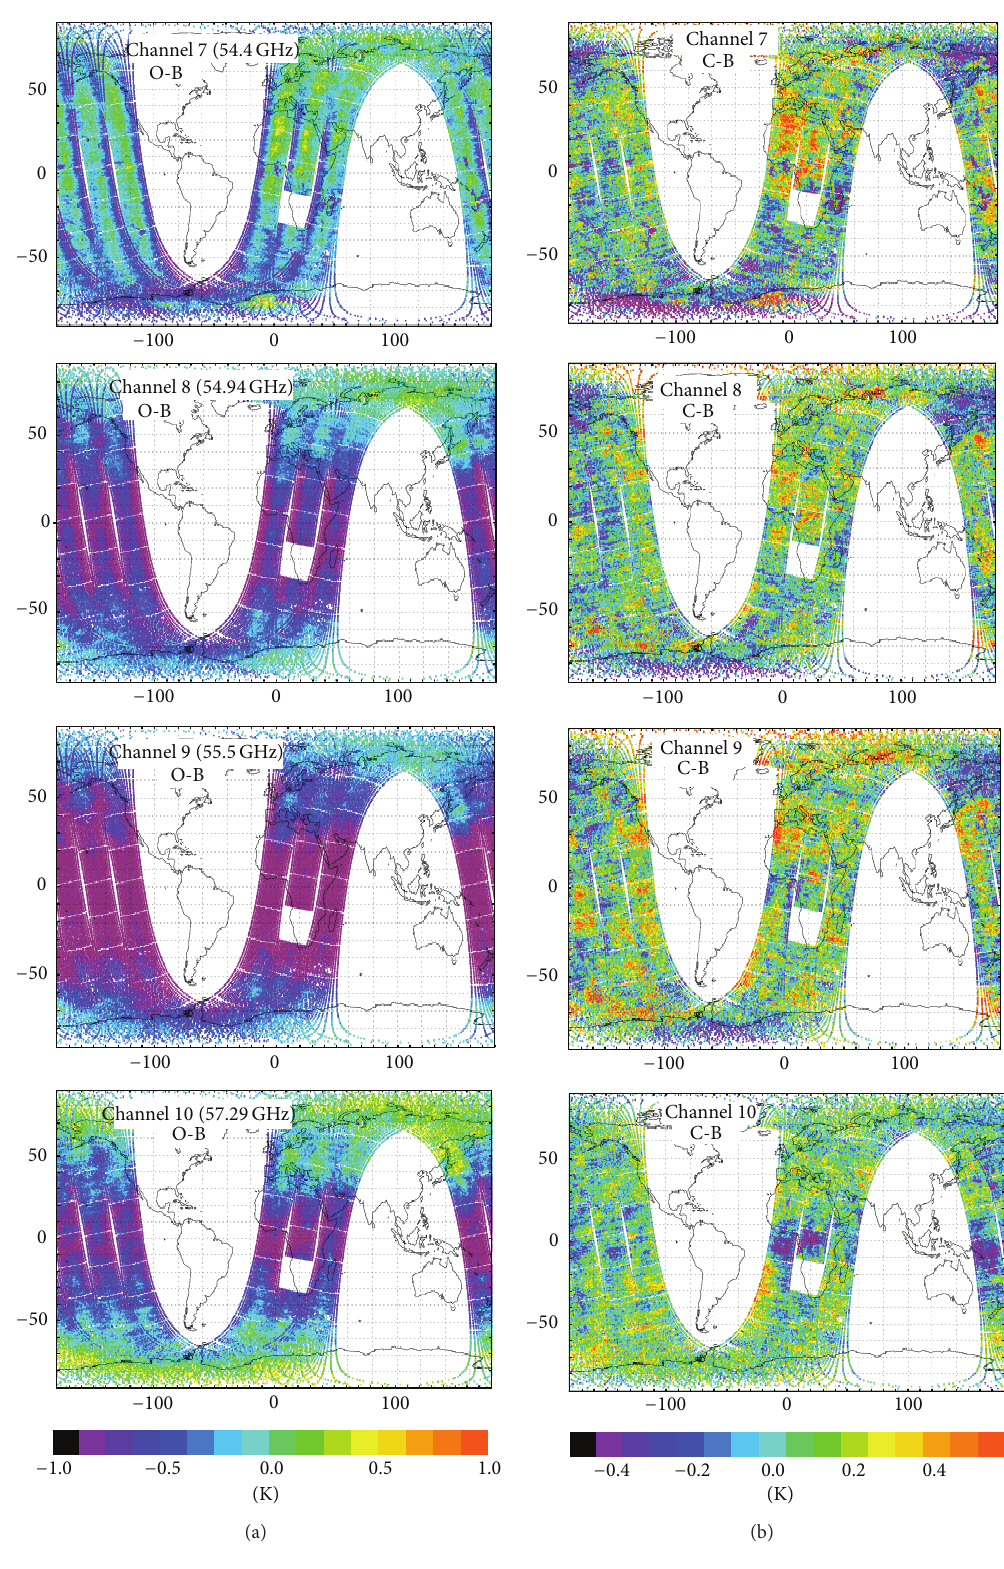
Figure 1: ATMS channels 7–10, difference between observations, and model background in the Met Office system at 0Z on 7 November 2013. LHS: uncorrected and RHS: